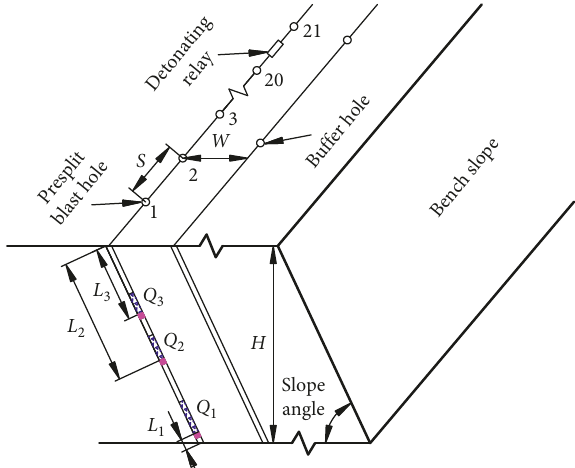
Figure 6: Sketch map of the charge structure and detonating network for presplit